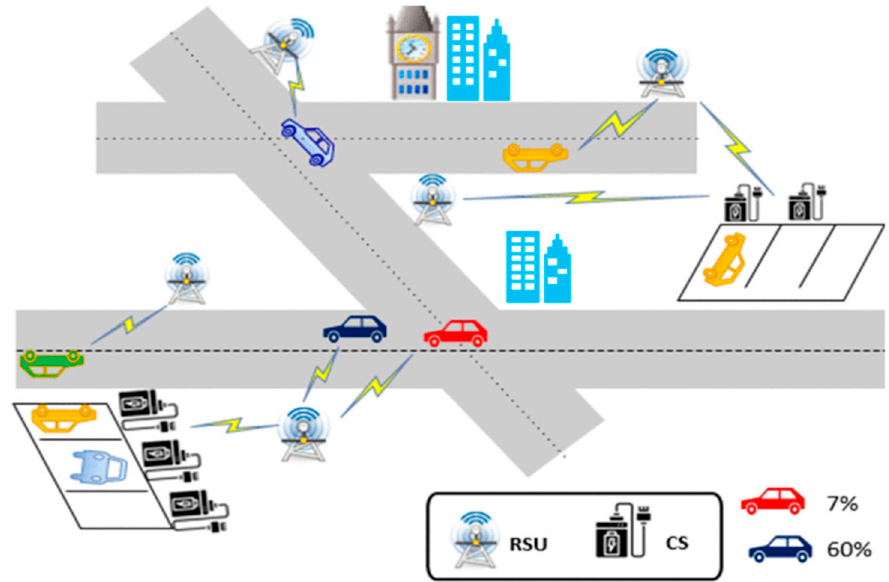
Figure 2. Conceptual architectural model for the vehicle-to-grid (V2G) and vehicle-to-infrastructure (V2I) systems.